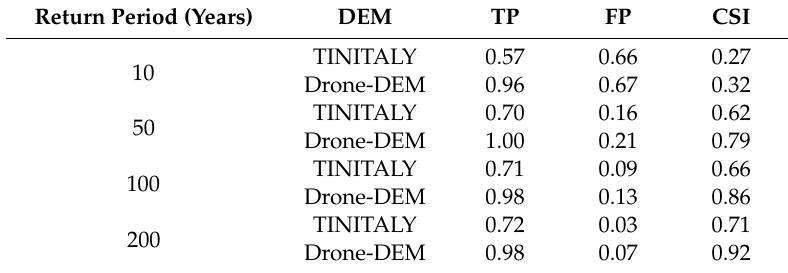
Table 3. Scores of the spatial comparison between the maximum asynchronous flood extension of the LiDAR-derived computational domain (reference map) and the ones derived from TINITALY and Drone-DEM 1 .